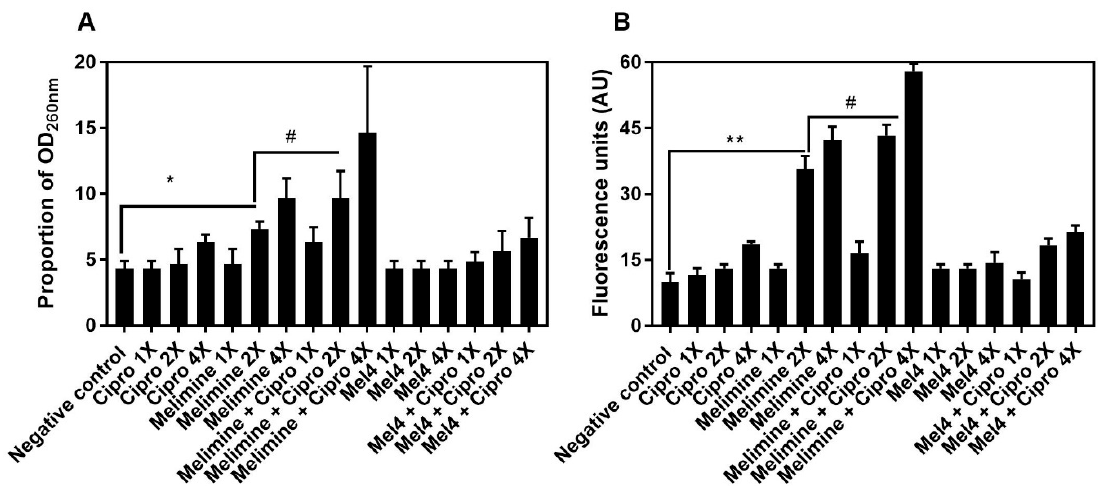
Figure 8. Increase in OD 260nm after release of DNA/RNA ( A ) and increase in fluorescence after interaction of Sytox green with released DNA/RNA ( B ) from pre-formed biofilm cells of S. aureus ATCC 25923. Leakage of nucleic acid from pre- formed (24 h) biofilms of S. aureus ATCC 25923 following treatments for 3 h with either of the two peptides and ciprofloxacin alone or in combination. The strain was made resistant to ciprofloxacin by passage of 30 days at a sub-MIC concentration. * represents significance ( p = 0.043) and ** indicates ( p ≤ 0.034) release of nucleic acid compared to the negative control. # represents significant ( p = 0.022) increase in the release of nucleic acid by the combination of melimine and ciprofloxacin compared to melimine alone.